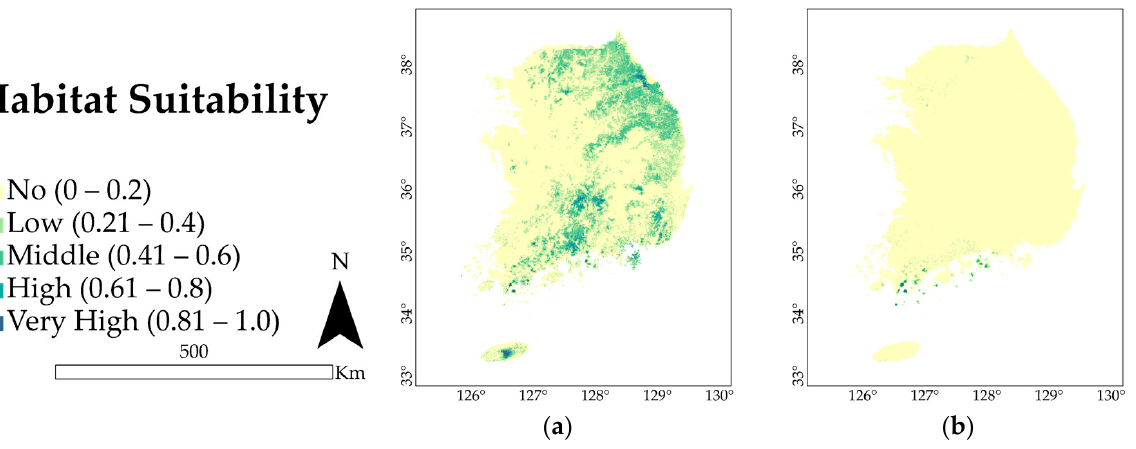
Figure 2. Predicted habitat suitability under current condition: ( a ) A. pictum ; ( b ) Q. acuta .